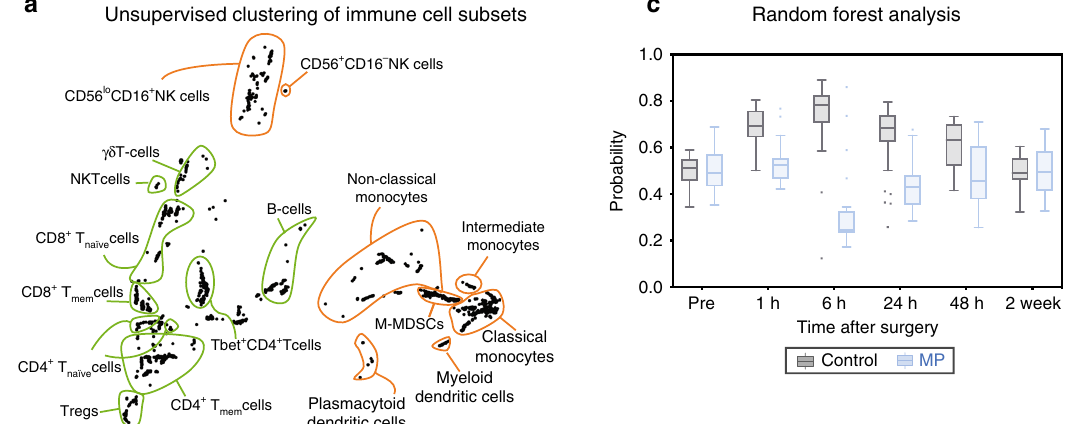
the immune atlas using a univariate statistical approach (Wilcoxon Rank Sum Test).